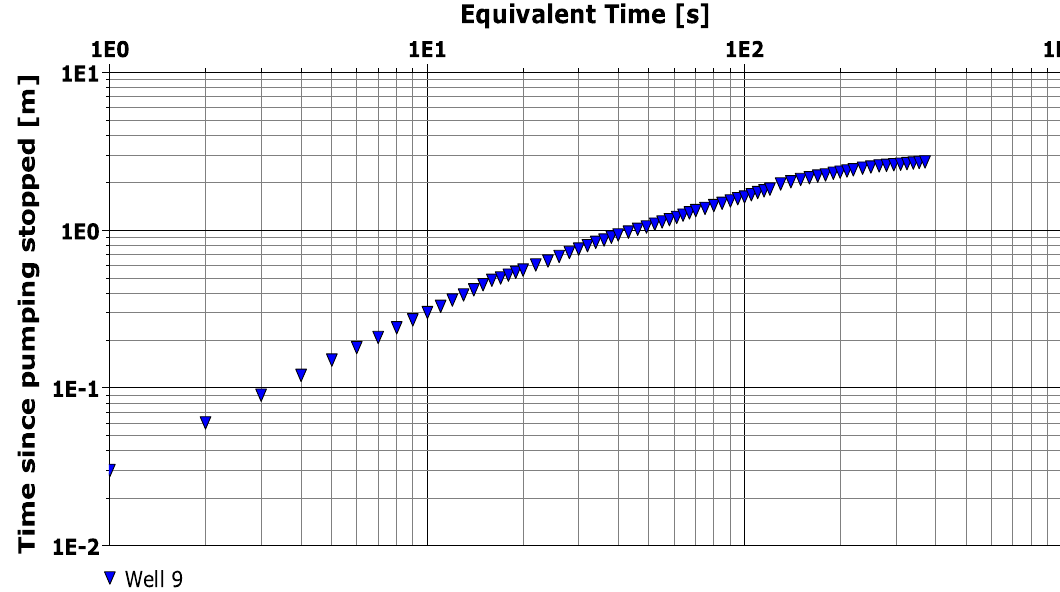
Fig. 14 Plotting of recovery rate of well-9 using aquifer mapping